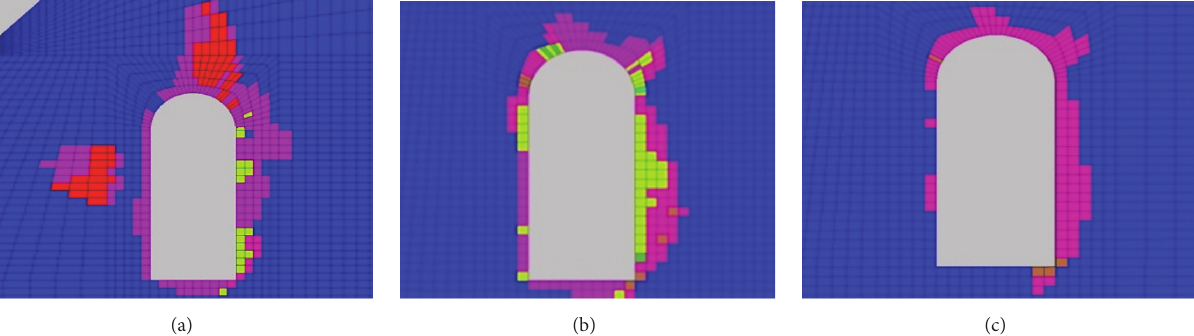
Figure 14: Plastic zones in the three schemes only considering gravity stress: (a) scheme I; (b) scheme II; (c) scheme III.